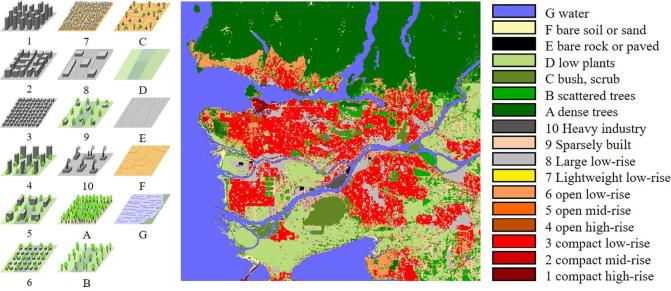
LCZ definition and an sample LCZ map of Vancouver, Canada. The left subfigure was modified from WUDAPT (Stewart, 2011).